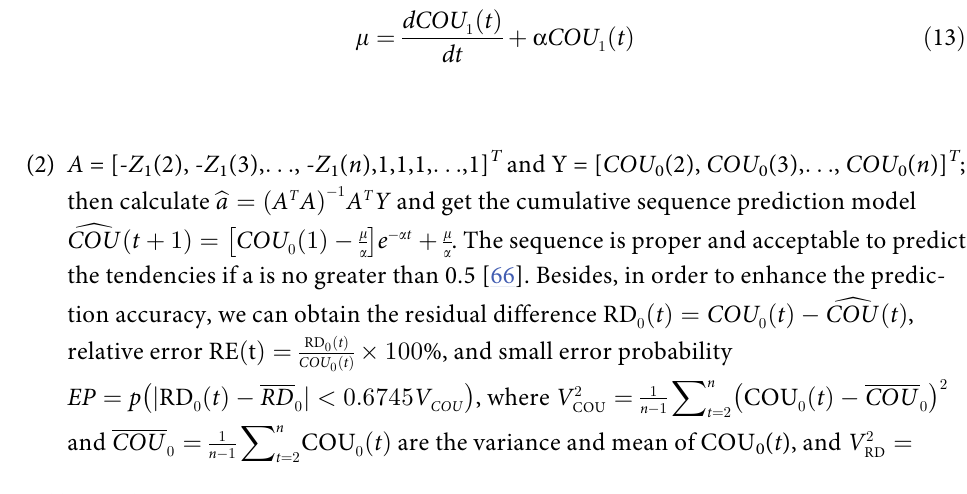
Table 2. Evaluation grades for